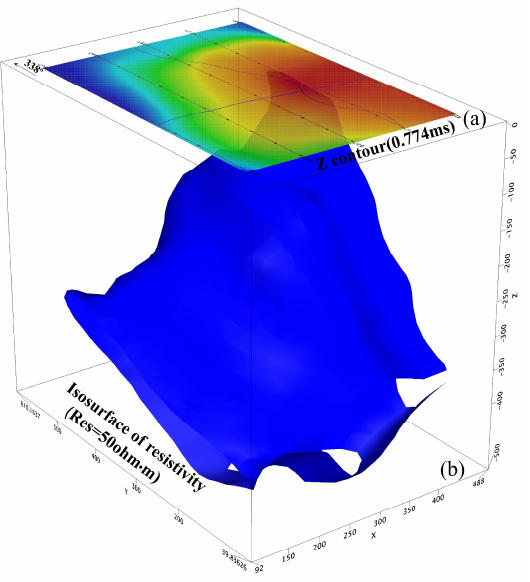
Figure 10. A 3D geoelectric model and multicomponent response characteristic diagram. ( a ) multi- component response characteristic diagram at 0.774 ms; ( b ) 3D geoelectric model.